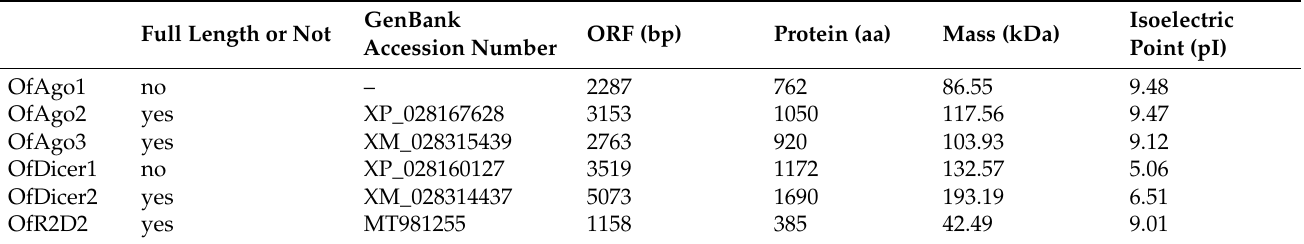
Table 1. Characteristics of core RNAi pathway transcripts and their deduced proteins from O. furnacalis